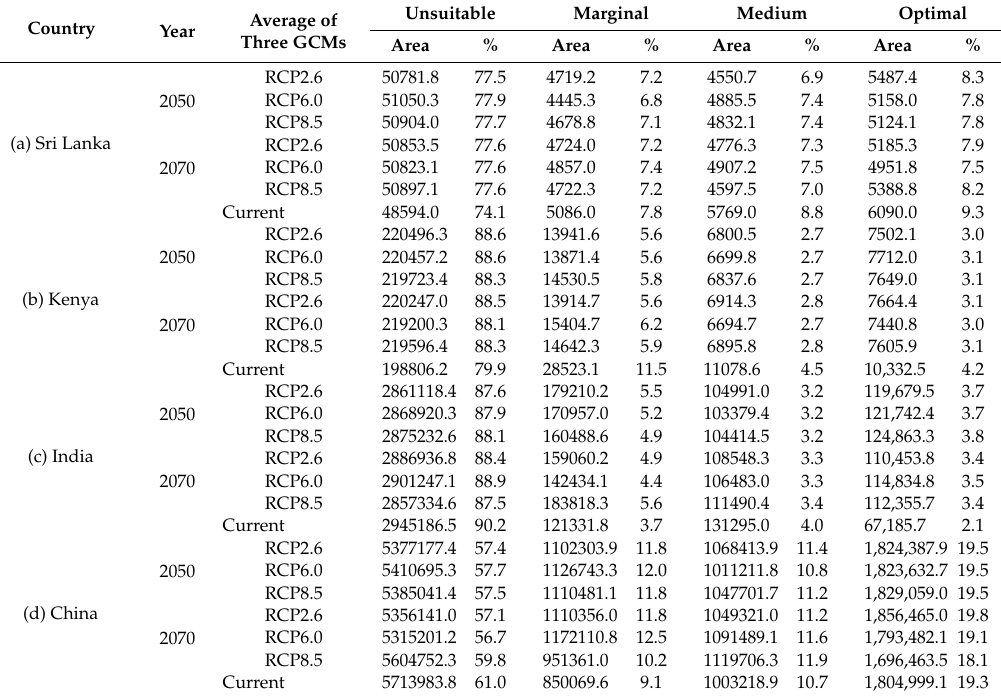
Figure 5. Current and future habitat suitability for Camellia sinensis in China ( a ) and change detection (loss or gain of suitability area) ( b ). Table 3. Areas (km 2 ) of suitable habitats for Camellia sinensis in ( a ) Sri Lanka, ( b ) Kenya, ( c ) India and ( d ) China under current and future climate conditions.